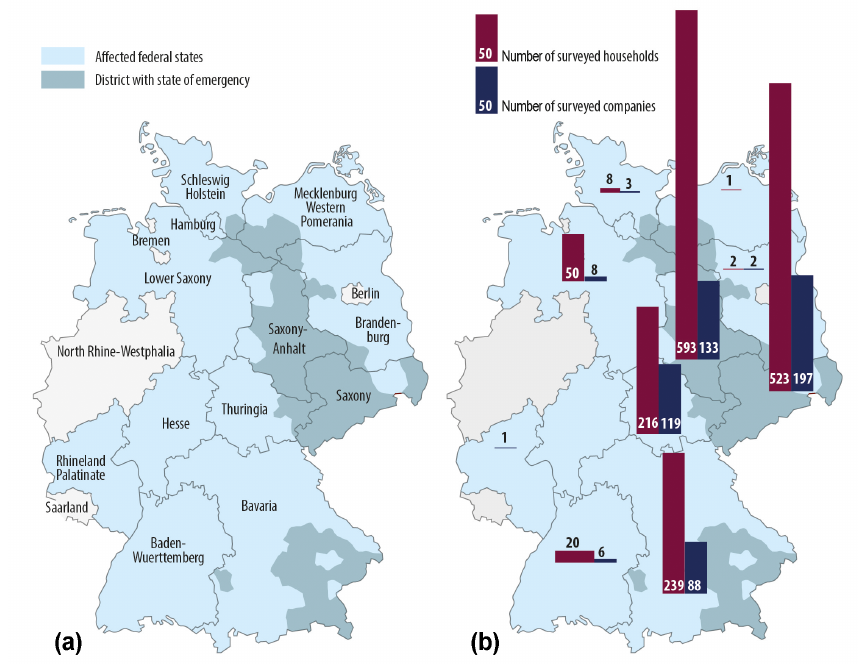
Figure 2. Geographic overview of affected federal states and districts that declared a state of emergency (a) as well as the number of surveyed households and companies (b)